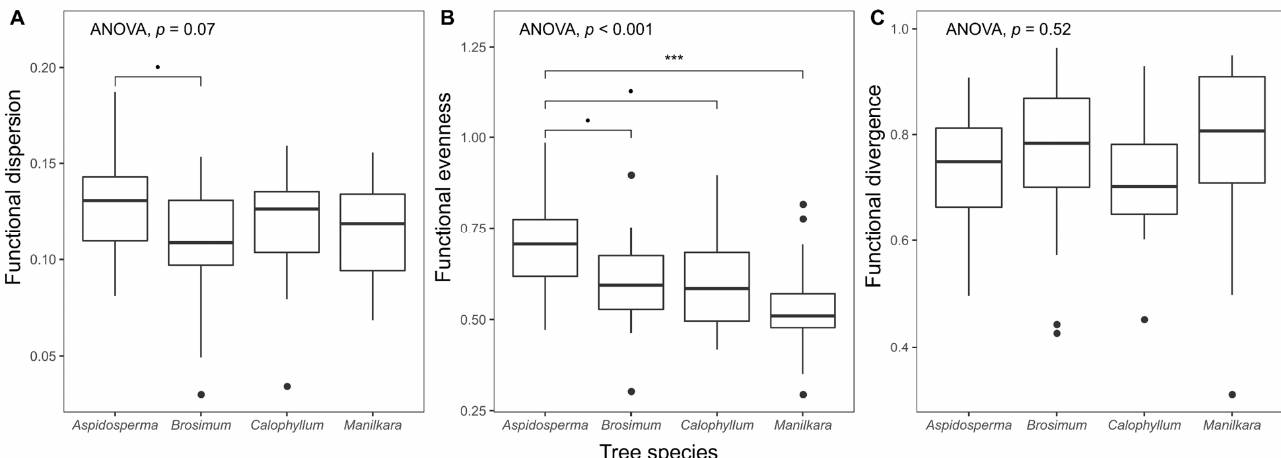
Figure 5. Functional diversity indices of crown epiphyte assemblages on focal host tree species. Boxplots show median, interquartile range and largest values within 1.5 times interquartile range below and above the 25th and 75th percentiles, respectively. Solid circles are outliers. Also given are p -values from analysis of variance, as well as the results of Tukey’s post- hoc tests (Significance codes: “***” p < 0.001; “·”: 0.05 ≤ p ≤ 0.1).